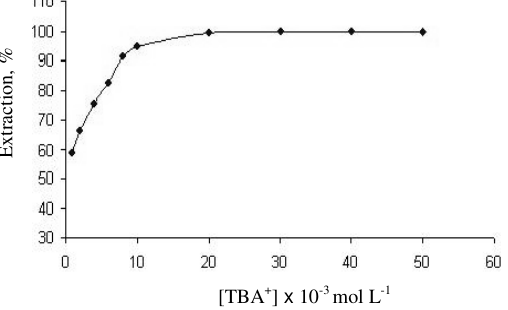
Figure 3. Effect of TBA + concentration on the extraction of palladium. ( Conditions: Pd(II) 50.0 ng mL -1 ; TMK 5.0 × 10 -5 mol L -1 ; CHCl 3 60.0 µL; NaClO 4 2.5 × 10 -2 mol L -1 and pH=3.0